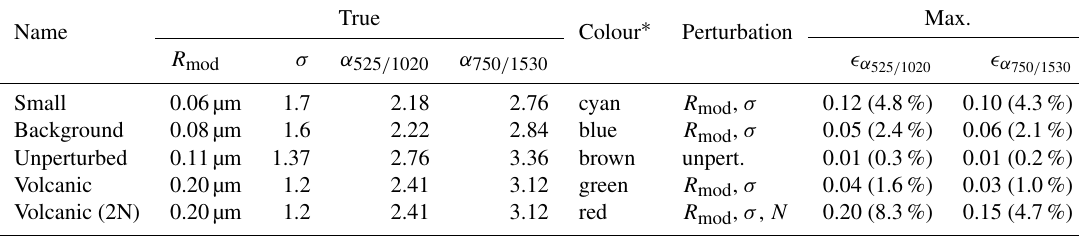
Table 2. Selected scenarios and associated maximum absolute (relative) parameter errors in Ångström exponents.